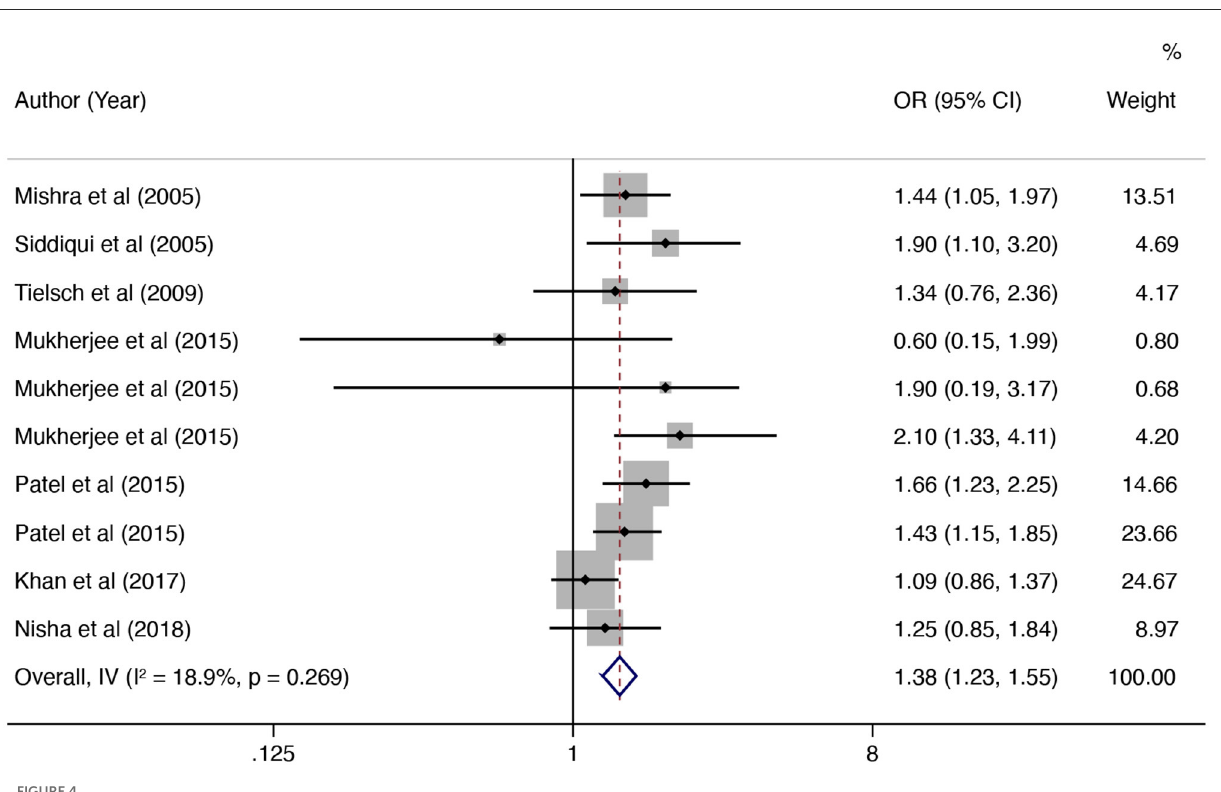
(74–76). We included 11 relevant studies exploring the effect of polluting cooking fuels on SGA; further eligible studies are needed to verify the